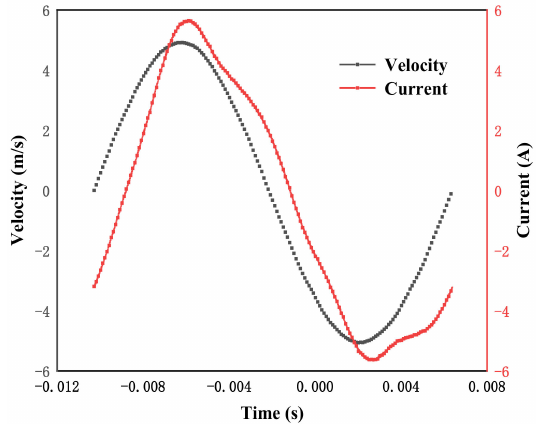
Figure 14. The current and velocity of the SDVLC, obtained from the